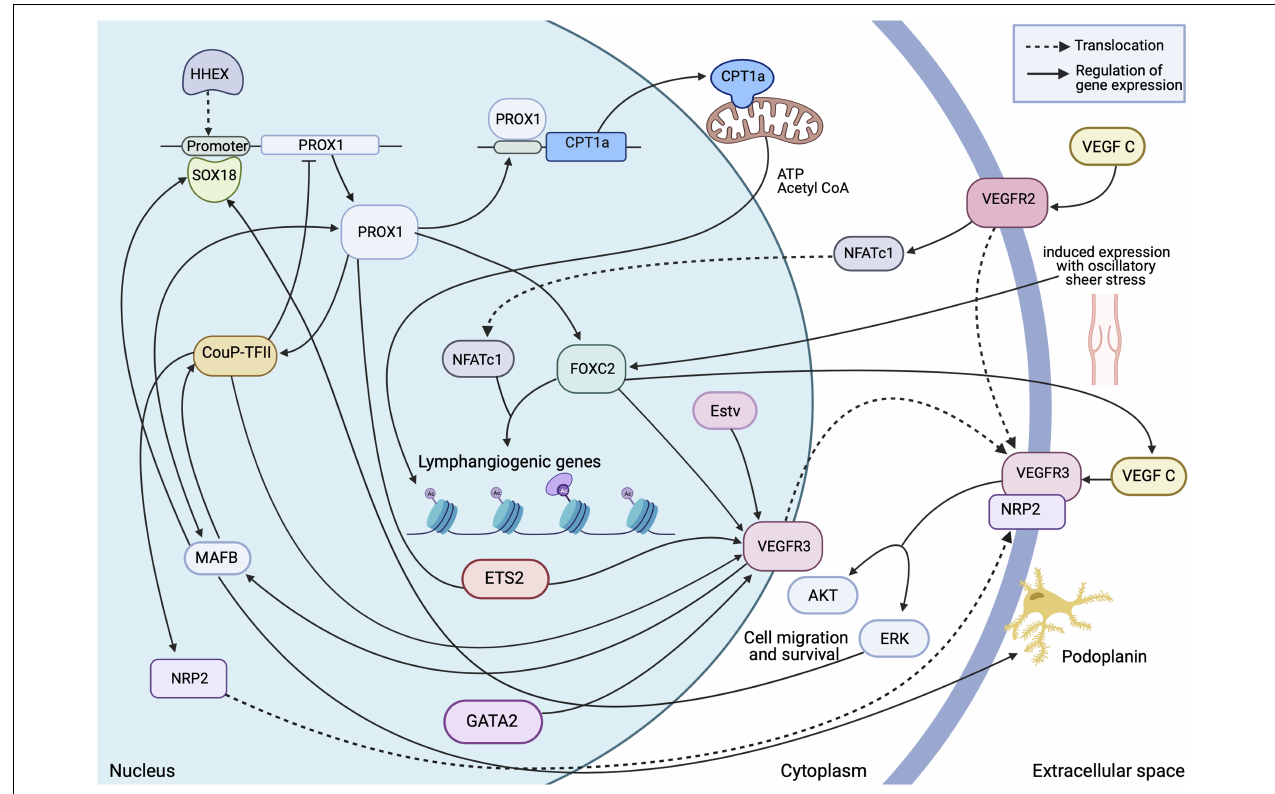
FIGURE 3 | Transcriptional insight into establishment and regulation of the quiescent lymphatic endothelial phenotype. A dynamic and interchangeable network of transcription factors are involved in the complex signalling which differentiates and maintains expression of essential proteins within the cell. This allows the cell to respond accordingly to external stimuli and retain structural stability in areas of high stress. Made with